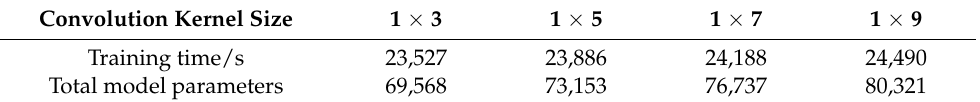
Table 3. Comparison of model parameters and training time with different convolution kernel sizes.